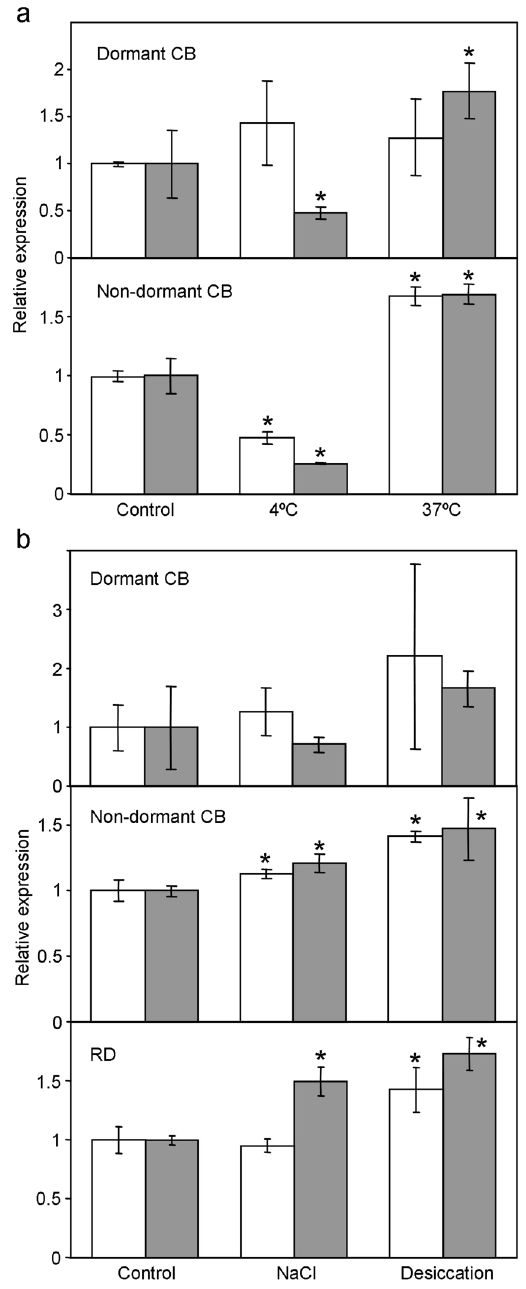
Figure 3. Effect of abiotic stresses on PpSAP1 expression in peach buds. Treatments at 4 °C and 37 °C ( a ), and NaCl 200 mM and desiccation ( b ) were performed during one (white bars) and three days (grey bars). Dormant and non-dormant reproductive buds from cultivar ‘Crimson Baby’ (CB) and non-dormant buds from ‘Rose Diamond’ (RD) were employed. An expression value of one is assigned to the control. Data are means from three biological samples with two technical replicates each, with error bars representing standard deviation. An asterisk indicates significant difference with the control at a confidence level of